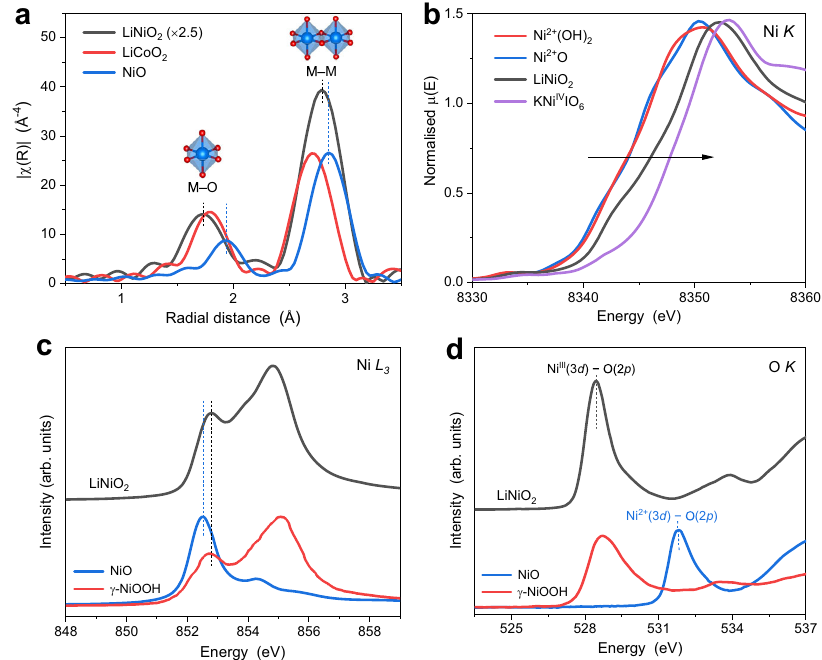
Fig. 3 | XAS characterisation of the as-prepared LiNiO 2 . a Fourier transforms of k 3 -weigted EXAFS spectra of LiNiO 2 , LiCoO 2 (R-3m) and NiO, and b XANES spectra of LiNiO 2 and Ni references (NiO, Ni(OH) 2 , and KNiIO 6 ) at the Ni K edge. The